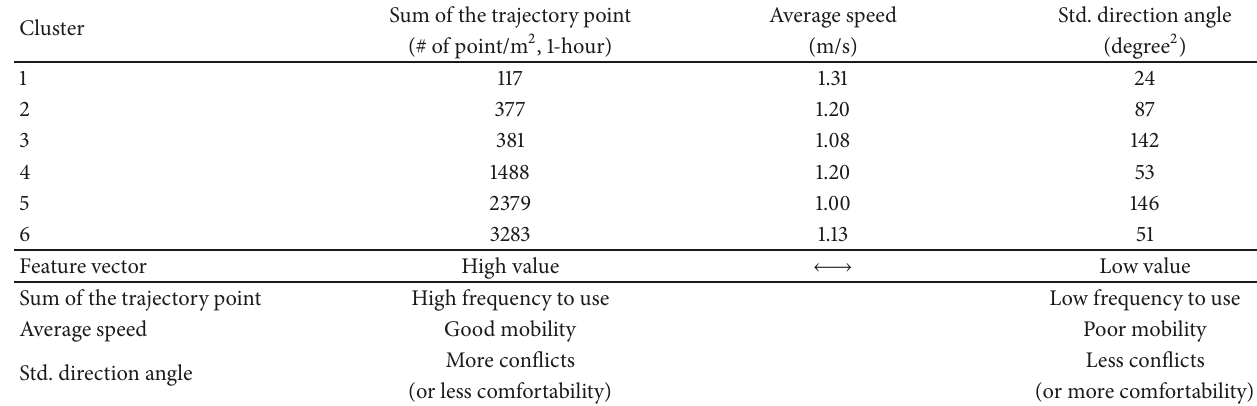
Table 2: Descriptions of feature vector by clusters and the meaning of the range of feature vector values.